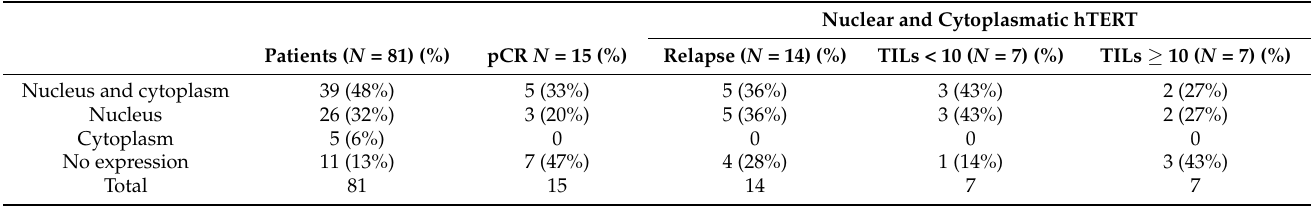
Table 3. Exclusive and concomitant expression detailing of hTERT between nucleus and cytoplasm.